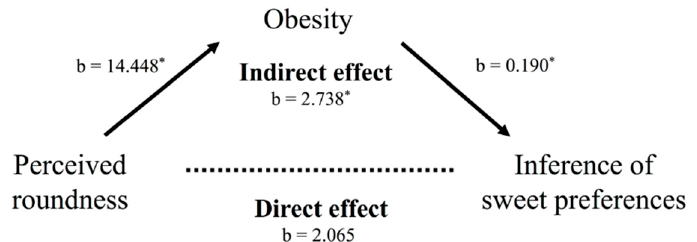
Figure 8. Model to predict the effect of facial shape on inference of sweet preference mediated by perceived matching. Standardized coefficients (b) are displayed. Asterisks indicate significant paths ( p < 0.05 *).